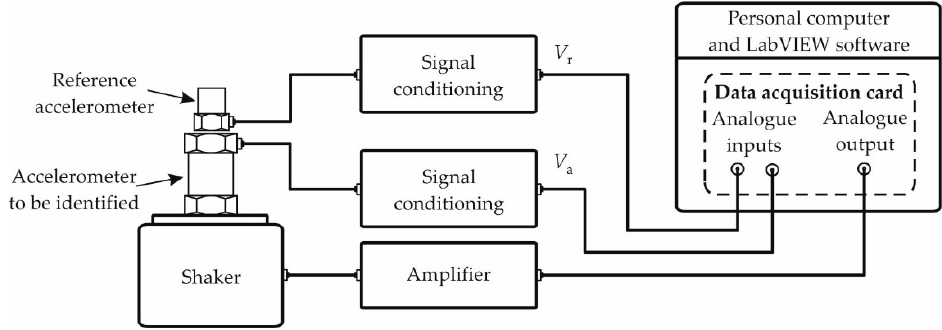
Figure 1. Block diagram of system for back-to-back identification of accelerometer.